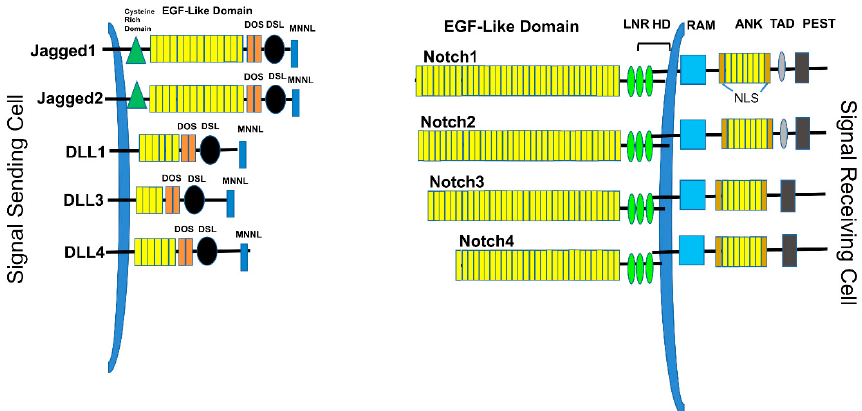
Figure 1. Notch ligands and receptors. The Signal-sending cell expresses Notch ligands, type I transmembrane proteins. These include Jagged1, Jagged2, DLL1, DLL3, and DLL4. Each ligand contains a short cytoplasmic tail, followed by the transmembrane domain, EGF-like repeats, a DOS domain, DLS binding domain, and MNNL domain. The signal-receiving cells express the Notch receptors, including Notch1, Notch2, Notch3, and Notch4. Each receptor contains EGF-like domains, LNR (Lin-Notch repeats), HD (heterodimerization domain), transmembrane domain, RAM (RBPJ-associated molecule), ANK (Ankyrin repeats), TAD (transactivation domain), and PEST (Pro-Glu-Ser-Thr) domains.